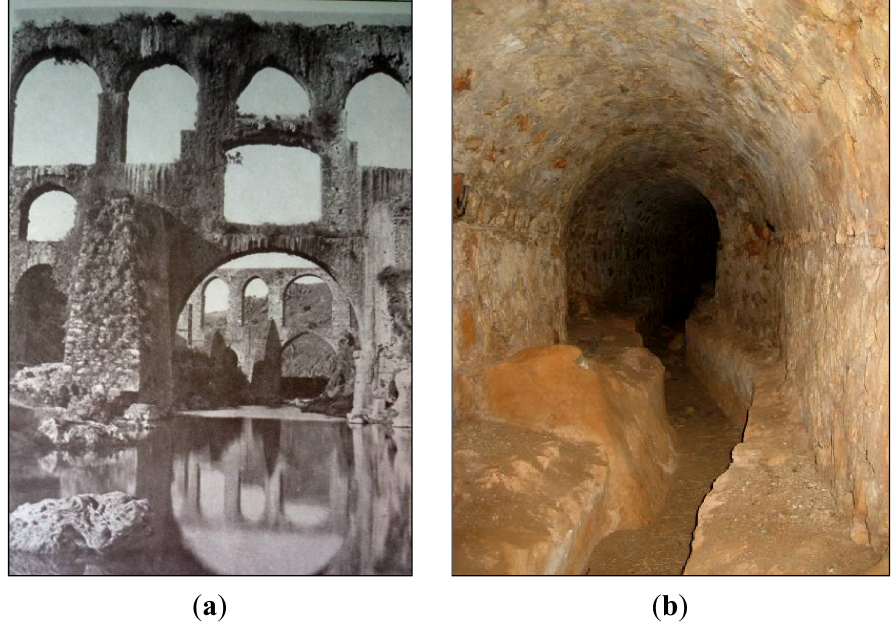
Figure 18. Ottoman period aqueducts: ( a ) The Alexander aqueduct in Smyrna, (picture by Frédéric Boissonnas, end of the 19th century); and ( b ) tunnel of the Pylos